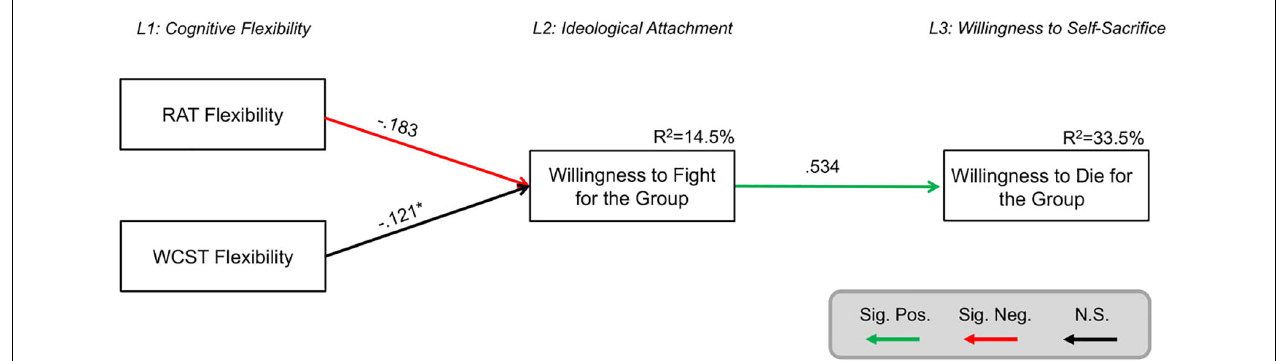
FIGURE 2 | Structural equation model predicting willingness to die for the group. All parameters shown are fully standardized. For unstandardized estimates, SEs, and confidence intervals, see Supplementary Data . Significant parameter estimates are shown in red and green bolded lines. Residual covariances between variables on the same level are allowed, but not shown for simplicity. Model controls for demographic variables (age, gender, and educational attainment). Significance level was p < 0.05. ∗ p = 0.10. L1, level 1; L2, level 2; and L3, level 3. Figure design was inspired by Kievit et al.